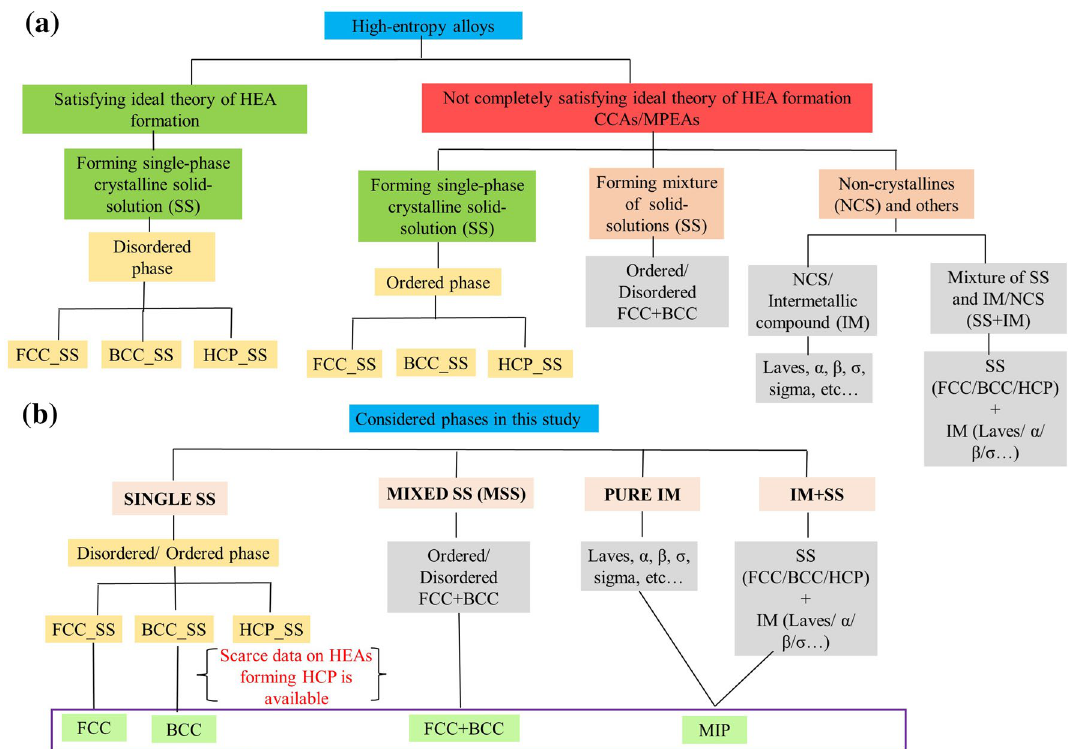
Figure 1. ( a ) Taxonomy of HEAs based on different definitions 30 . ( b ) Phases considered in this work to classify the data based on the existing